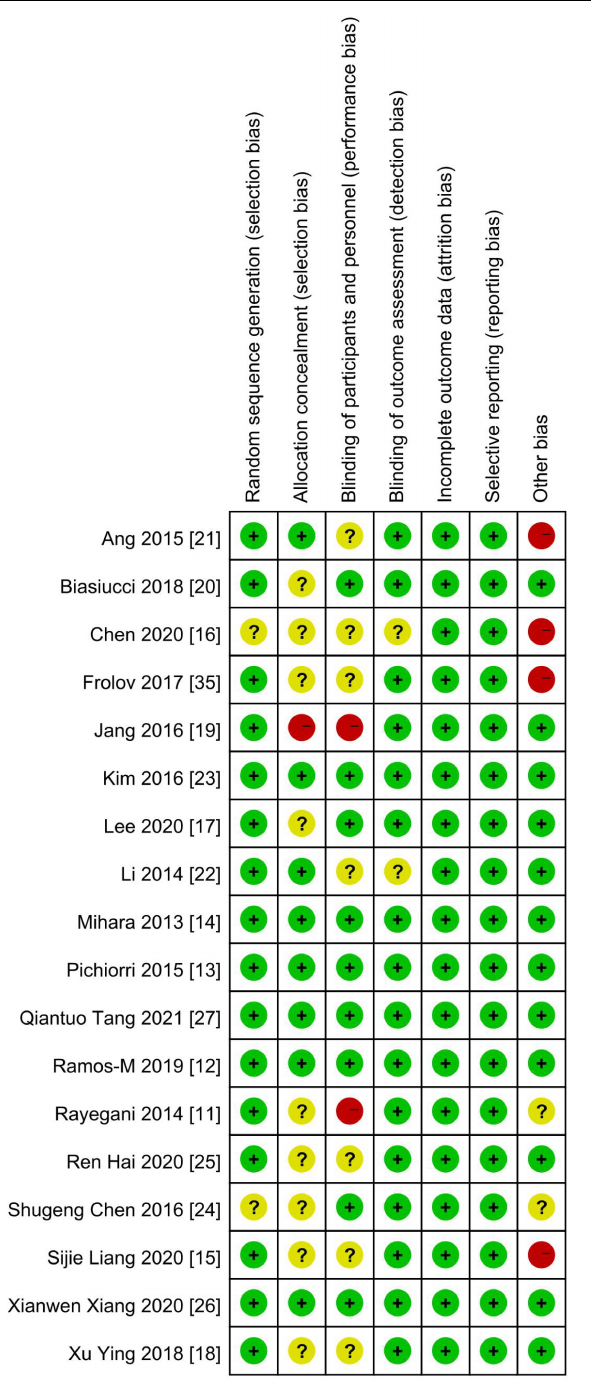
FIGURE 3 | Summary of the risk of bias: review authors’ judgments about each risk-of-bias item in each included study. “+,” low risk of bias; “?,” unclear risk of bias; “–,” high risk of bias.